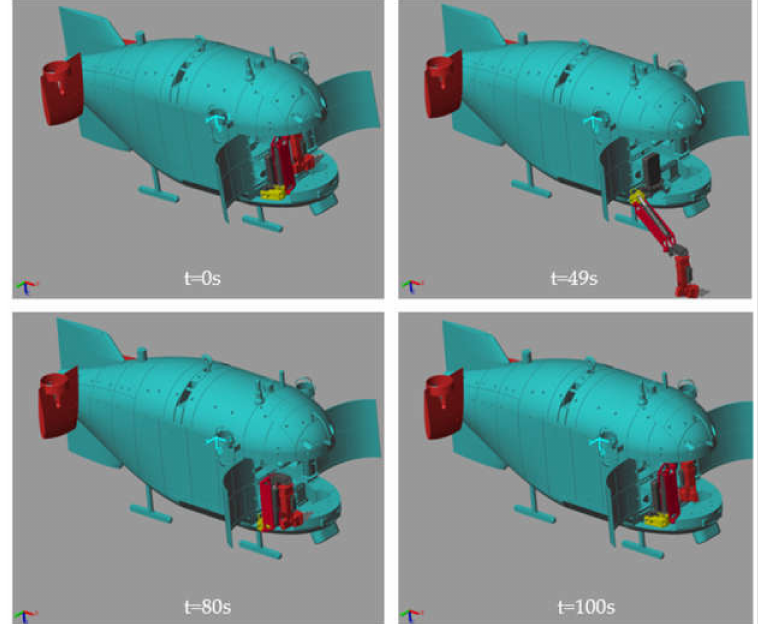
Figure 3. The process of free-floating manipulation during simulation.